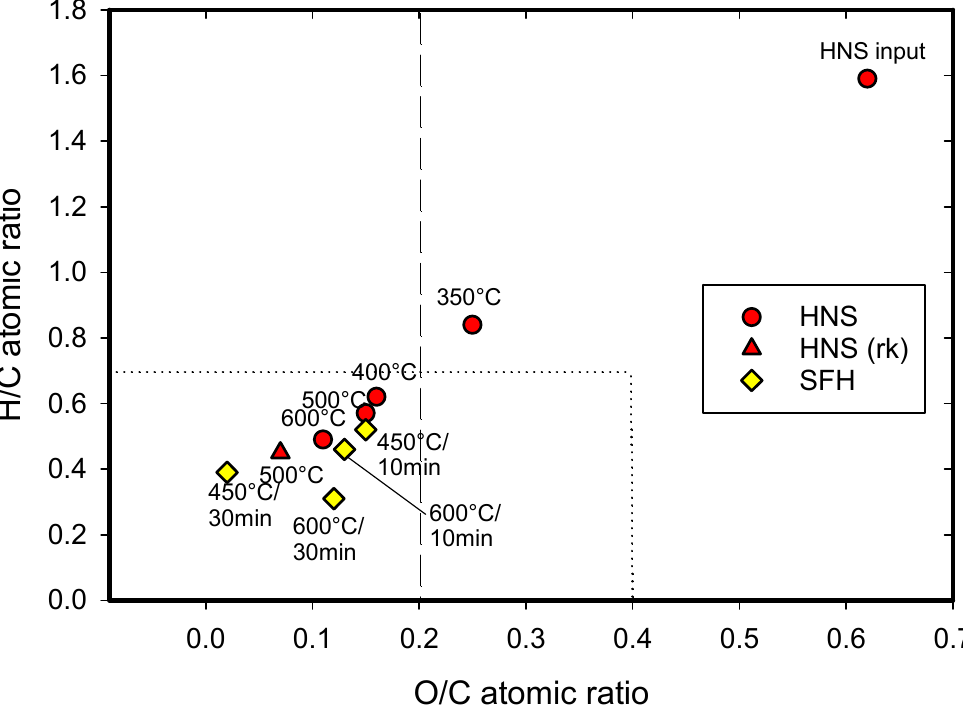
Figure 4. Effect of the process temperature on the elemental composition of HNS- (red symbols) and SFH-biochar (yellow diamonds) shown in the van-Krevelen diagram. The long dashed line shows an orientation line for the biochar stability at O / C = 0.2 according to [18] and the shortly dashed lines show the boundary area for quality biochar according to the European Biochar Certificate (EBC) [19]; rk ... rotary kiln, HNS ... hazelnut shells, SFH ... sunflower husks.